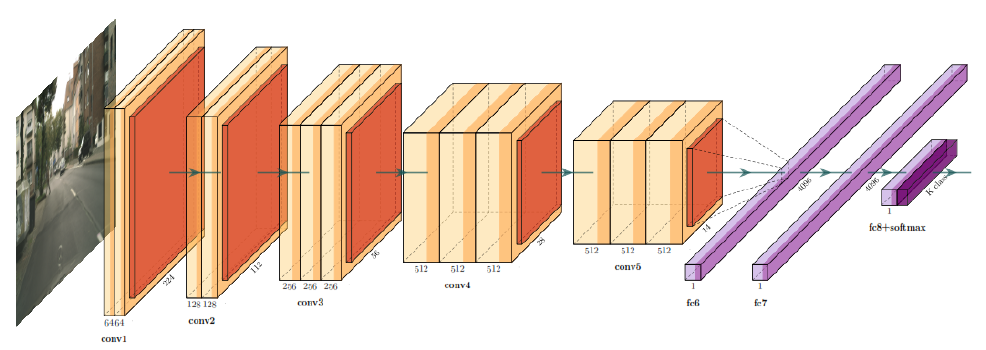
Figure 8. Modified convolutional neural network VGG-16. Algorithm 1 calculates the segmentation of input images used to process the